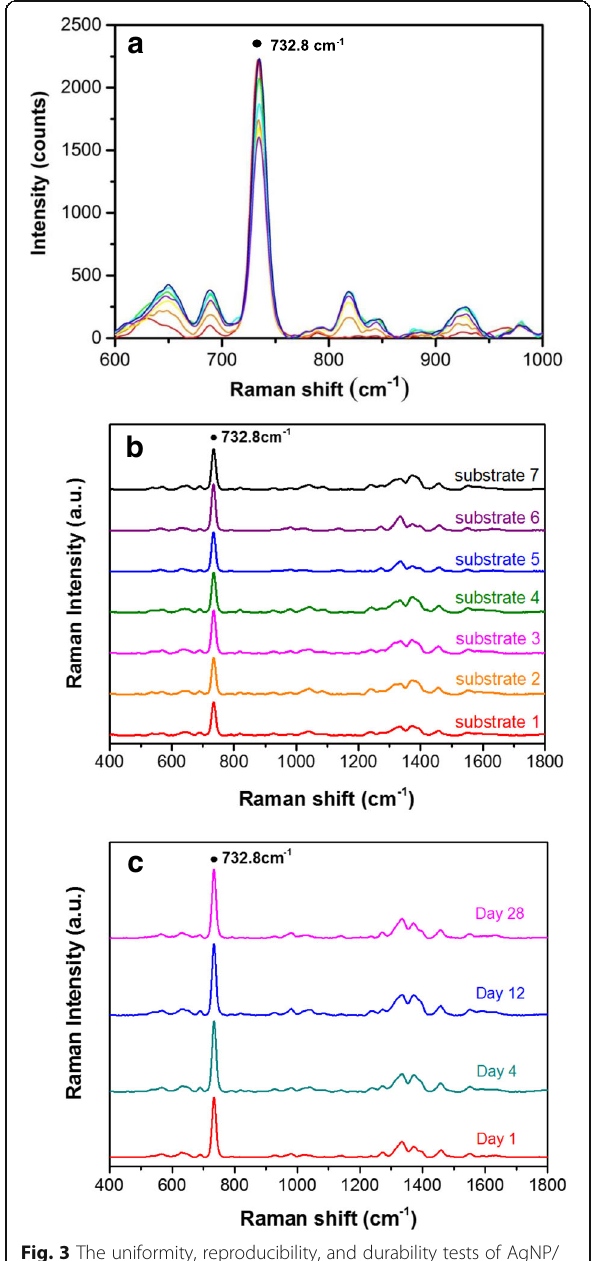
Fig. 3 The uniformity, reproducibility, and durability tests of AgNP/ AAO surface-enhanced Raman scattering (SERS) substrate. a SERS spectra of adenine (10 − 4 M) obtained at seven spots separated by about 10 – 15 mm on the SERS substrate. b SERS spectra of adenine (10 − 4 M) obtained at seven different SERS substrates. c SERS spectra of adenine (10 − 4 M) obtained at delays of 1, 4, 12, and 28 days after